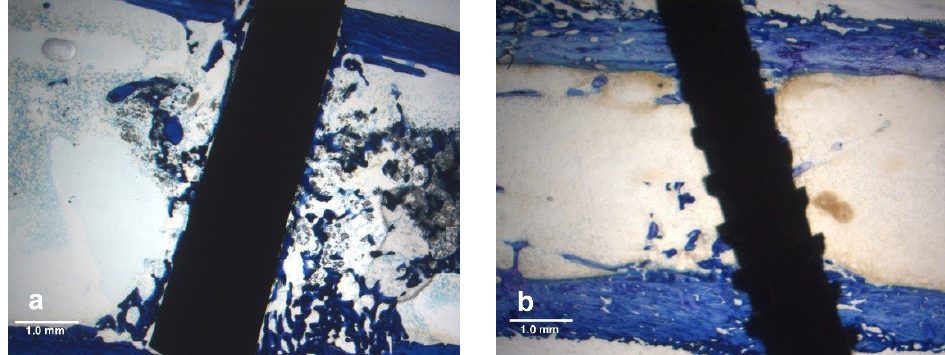
Figure 3. Lateral cross-sectional toluidine blue stain section at 2× magnification in a rat tibia bone marrow implant model ( a ) Epoxy carbon fiber PMC; ( b ) Titanium-6Al-4V